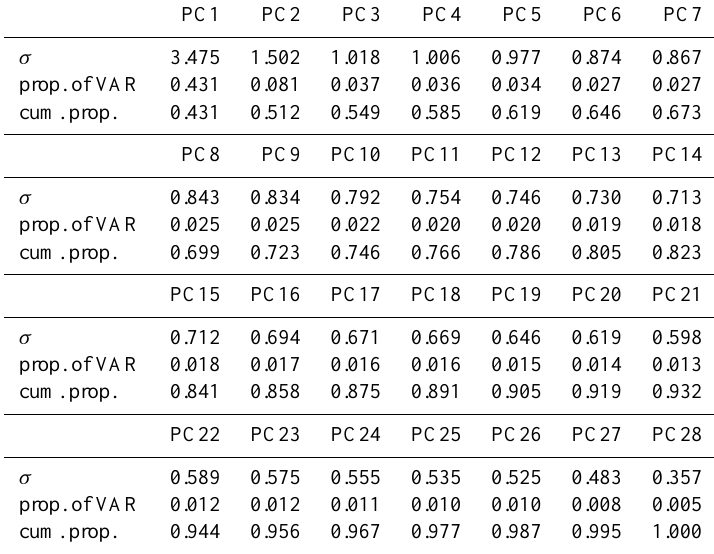
Figure 5a. Analysis of the coefficient of variation via an “environment assessment” for a designed data set. The data are generated in the same way as in the previous analysis (see Fig. 3). Subfigure (a) illustrates the derivation of a single summary value for the central pixel P c (blue) from the data of the surrounding environment w (red). The example here investigates how many values within the environment are larger than the central value. This is repeated for all image pixels (except for boundary pixels), resulting in the rightmost picture. Table 1. Overview on the 28 calculated principle components (PCs) regarding their accounted proportion of variance. In each column, the components show their specific standard deviation ( σ ), proportion of variance (prop. of VAR) and cumulative proportion of variance (cum. prop.). PC1